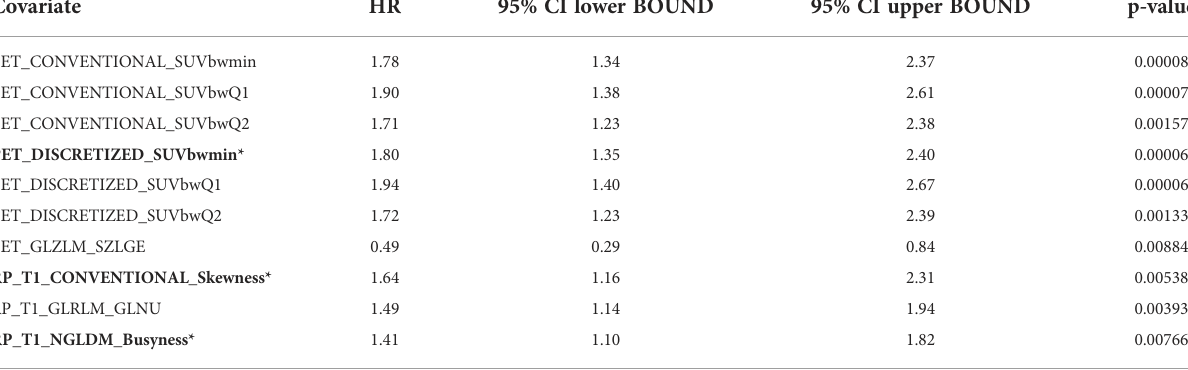
TABLE 4 Feature selection for PFS.